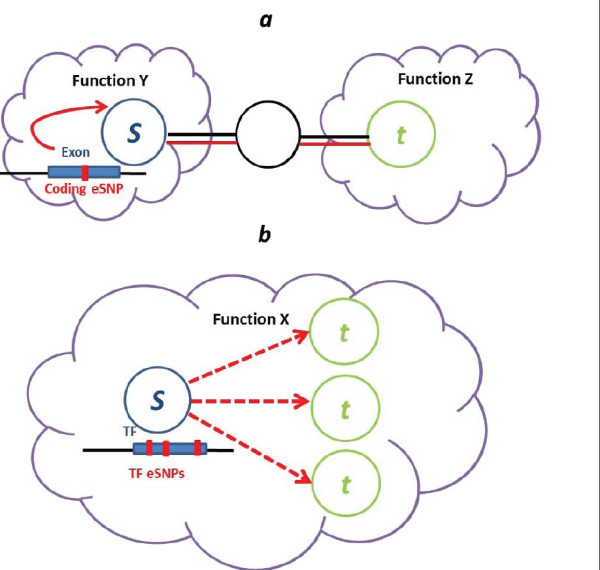
Summary illustration - two suggested modes of trans regulation. (a) Exon variation often acts by a local cis effect, delineating shorter paths of interacting proteins across functional clusters of the PPI network. (b) TF variation frequently acts via a modular regulation mechanism, with multiple targets that share a function with the TF source. (See Figure 3 legend for further details.) eSNP, expression single nucleotide polymorphisms.